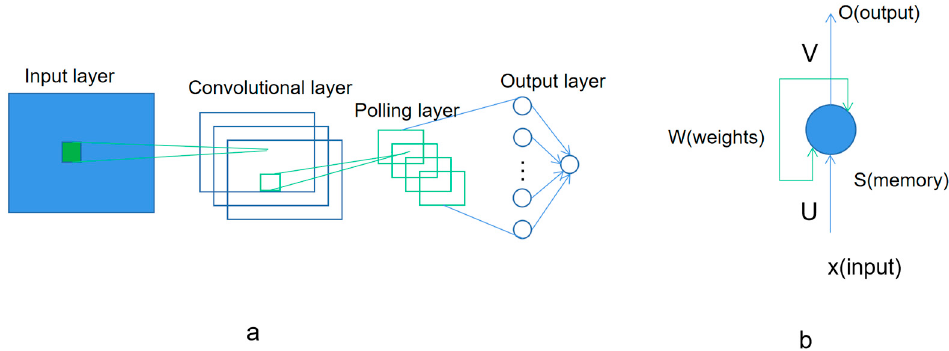
Figure 4. The base model of ( a ) the convolutional neural network and ( b ) the recurrent neural networks.